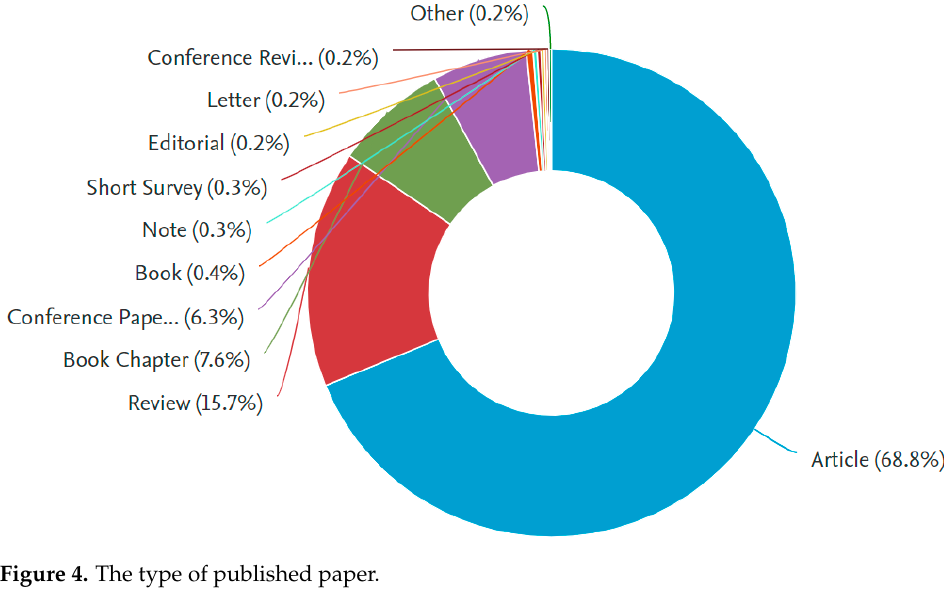
Figure 4. The type of published paper.